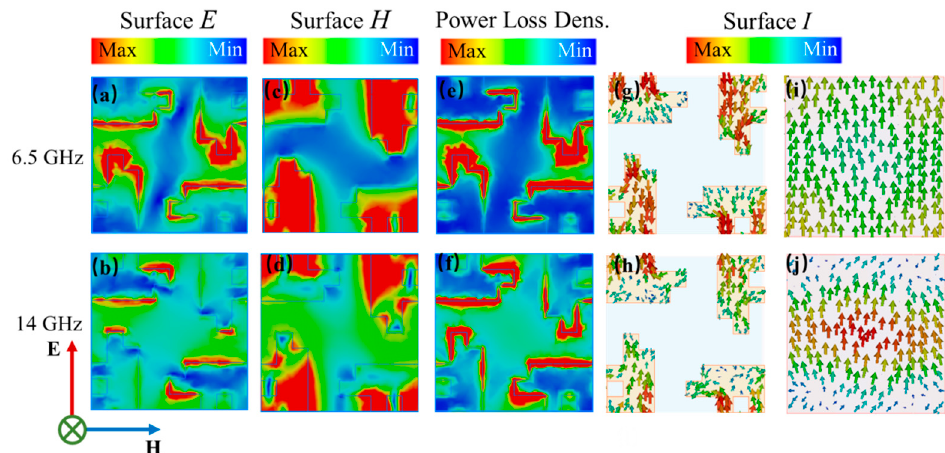
Figure 4. Electromagnetic responses of the proposed absorber under normally incident TE waves at 6.5 GHz and 14 GHz. The distributions of ( a , b ) electric field ( c , d ) magnetic field ( e , f ) power loss density. Distributions of surface currents on ( g , h ) the ITO resistive metasurface and ( i , j ) the bottom ground layer.